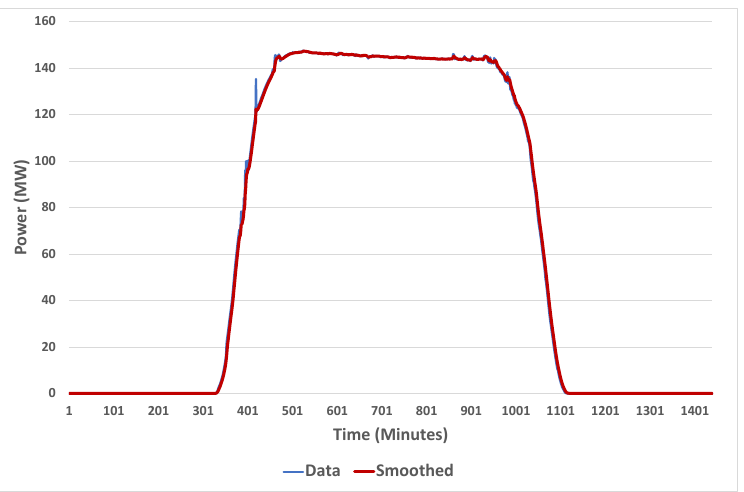
Figure 2. Clear day output in Broken